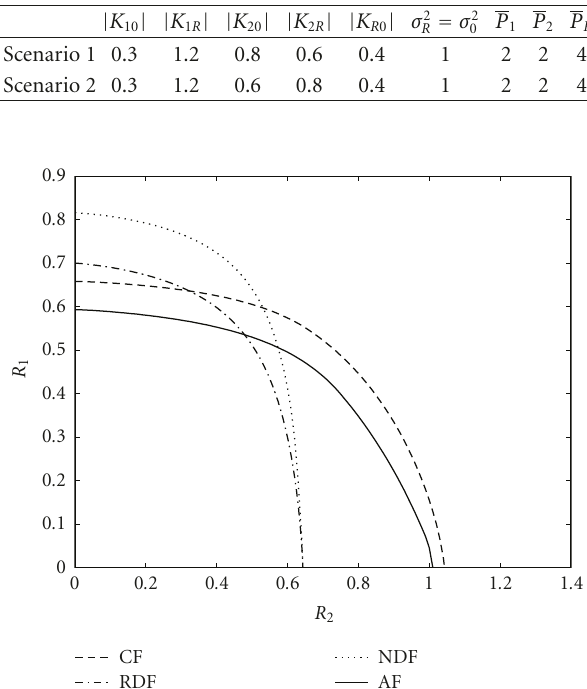
Figure 3: Achievable rate regions obtained via jointly optimal power and resource allocation in Scenario 1.